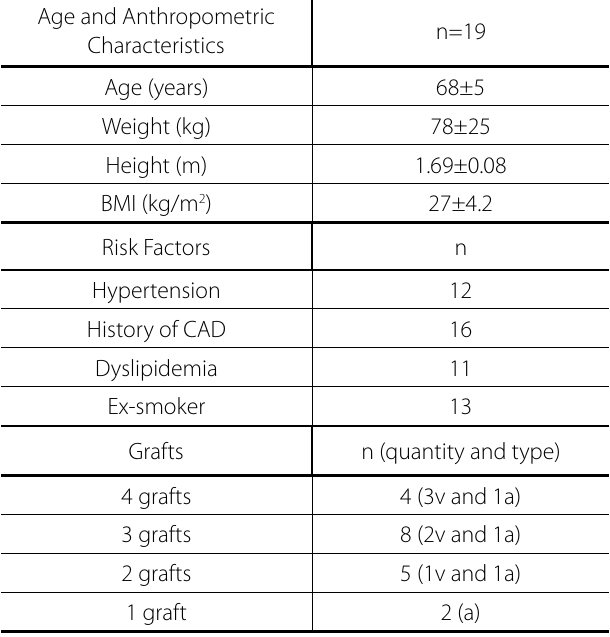
Table 1. Age, anthropometric characteristics, risk factors and number and type of grafts used in coronary artery bypass surgery.